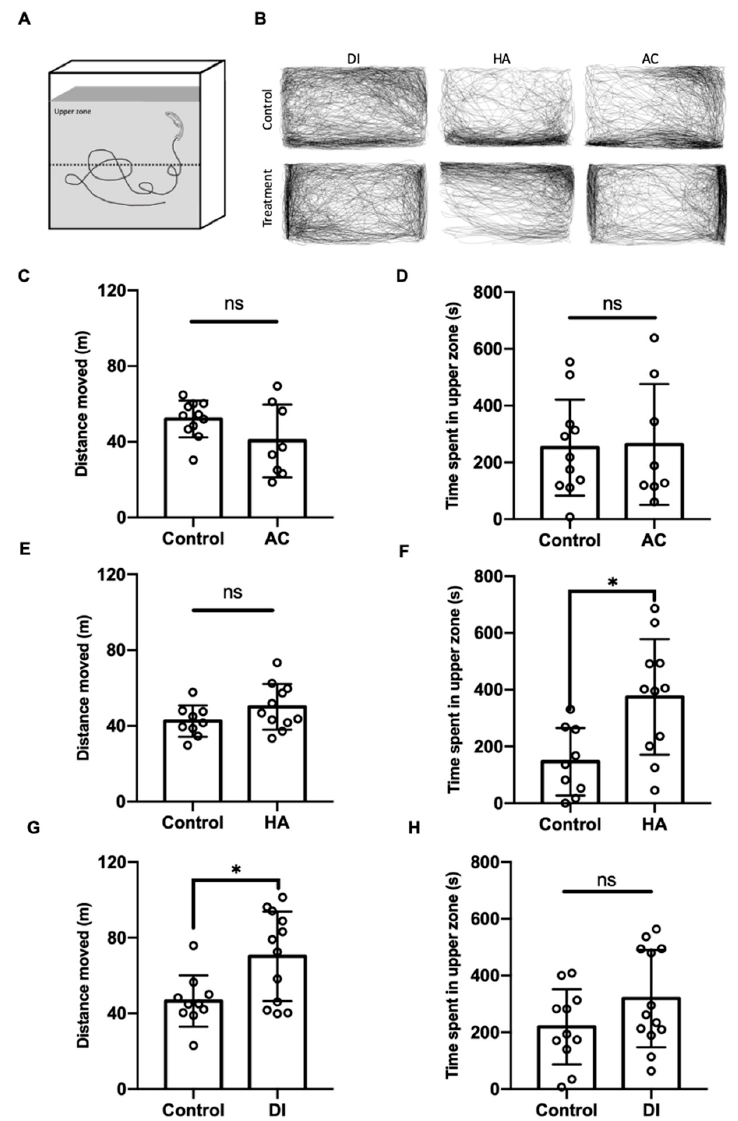
Figure 6. Effects of AC, HA, and DI treatments in a novel tank diving test. ( A ) Schematic of the novel tank diving test. ( B ) Trajectories of fish moving after exposure to AC, HA, or DI water. ( C , E , G ) Total moving distance of fish was calculated after exposure to different stressors. ( D , F , H ) The period fish stayed in upper zone was analyzed after exposure to different stressors. In AC treatment, n = 11 for the treatment group, n = 8 for the treatment group. In HA treatment, n = 9 for control group; n = 11 for the treatment group. In DI treatment, n = 11 for control group; n = 13 for the treatment group. The asterisks (*) indicate significant differences between the control and treatment groups.; ns indicates that no significant difference was found between the control and treatment groups. Values are means ± SD ( p < 0.05 (Student’s t -test)).